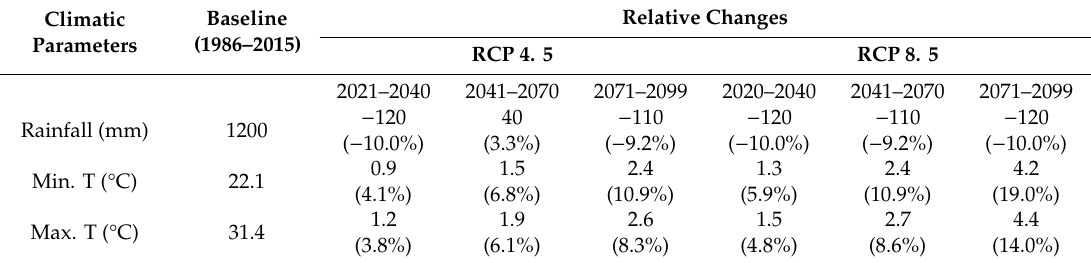
Figure 8. Temporal courses of crop water productivity (CWP). Table 6. Changes in rainfall, minimum and maximum temeperature for future periods relative to mean of 1986–2015 under RCP 4.5 and RCP 8.5